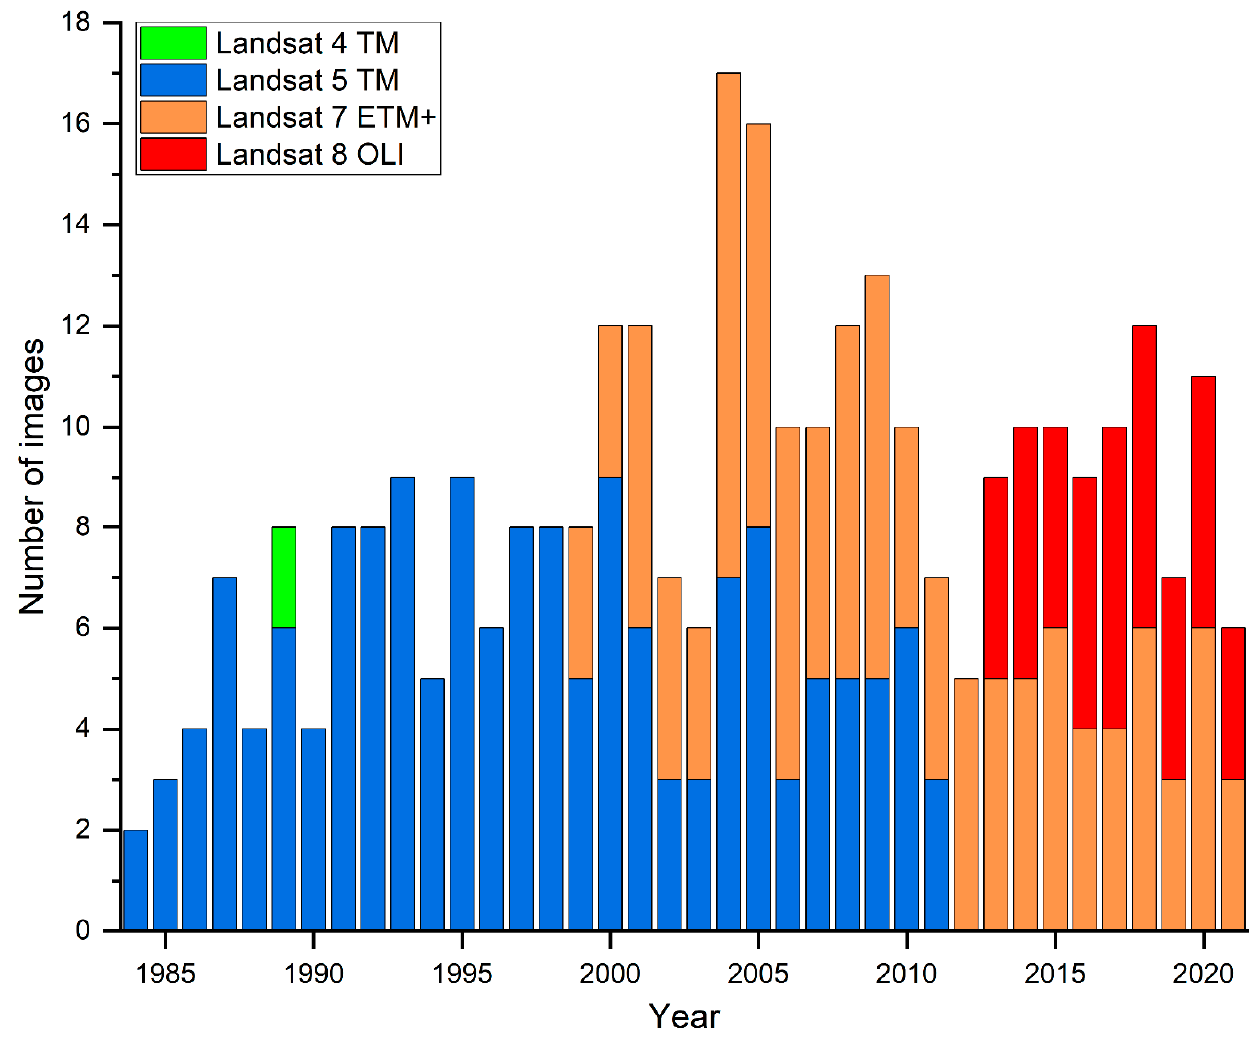
Figure 2. The number of Landsat images (Path 121 and Row 34) used for TMZ mapping. TM, Thematic Mapper; ETM+, Enhanced Thematic Mapper Plus; OLI, Operational Land Imager.